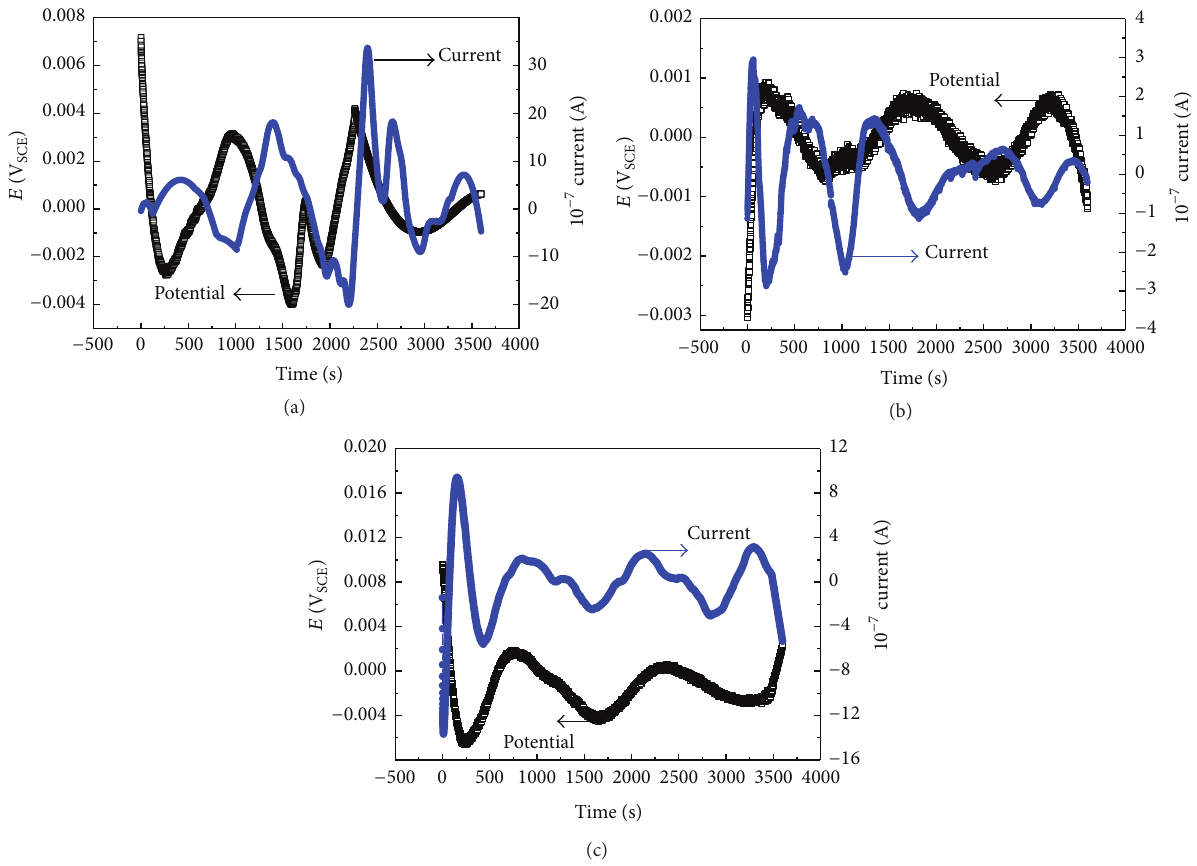
Figure 6: Electrochemical noise pattern of the passive films formed on (a) X70, (b) X80, and (c) X100 pipeline steels.